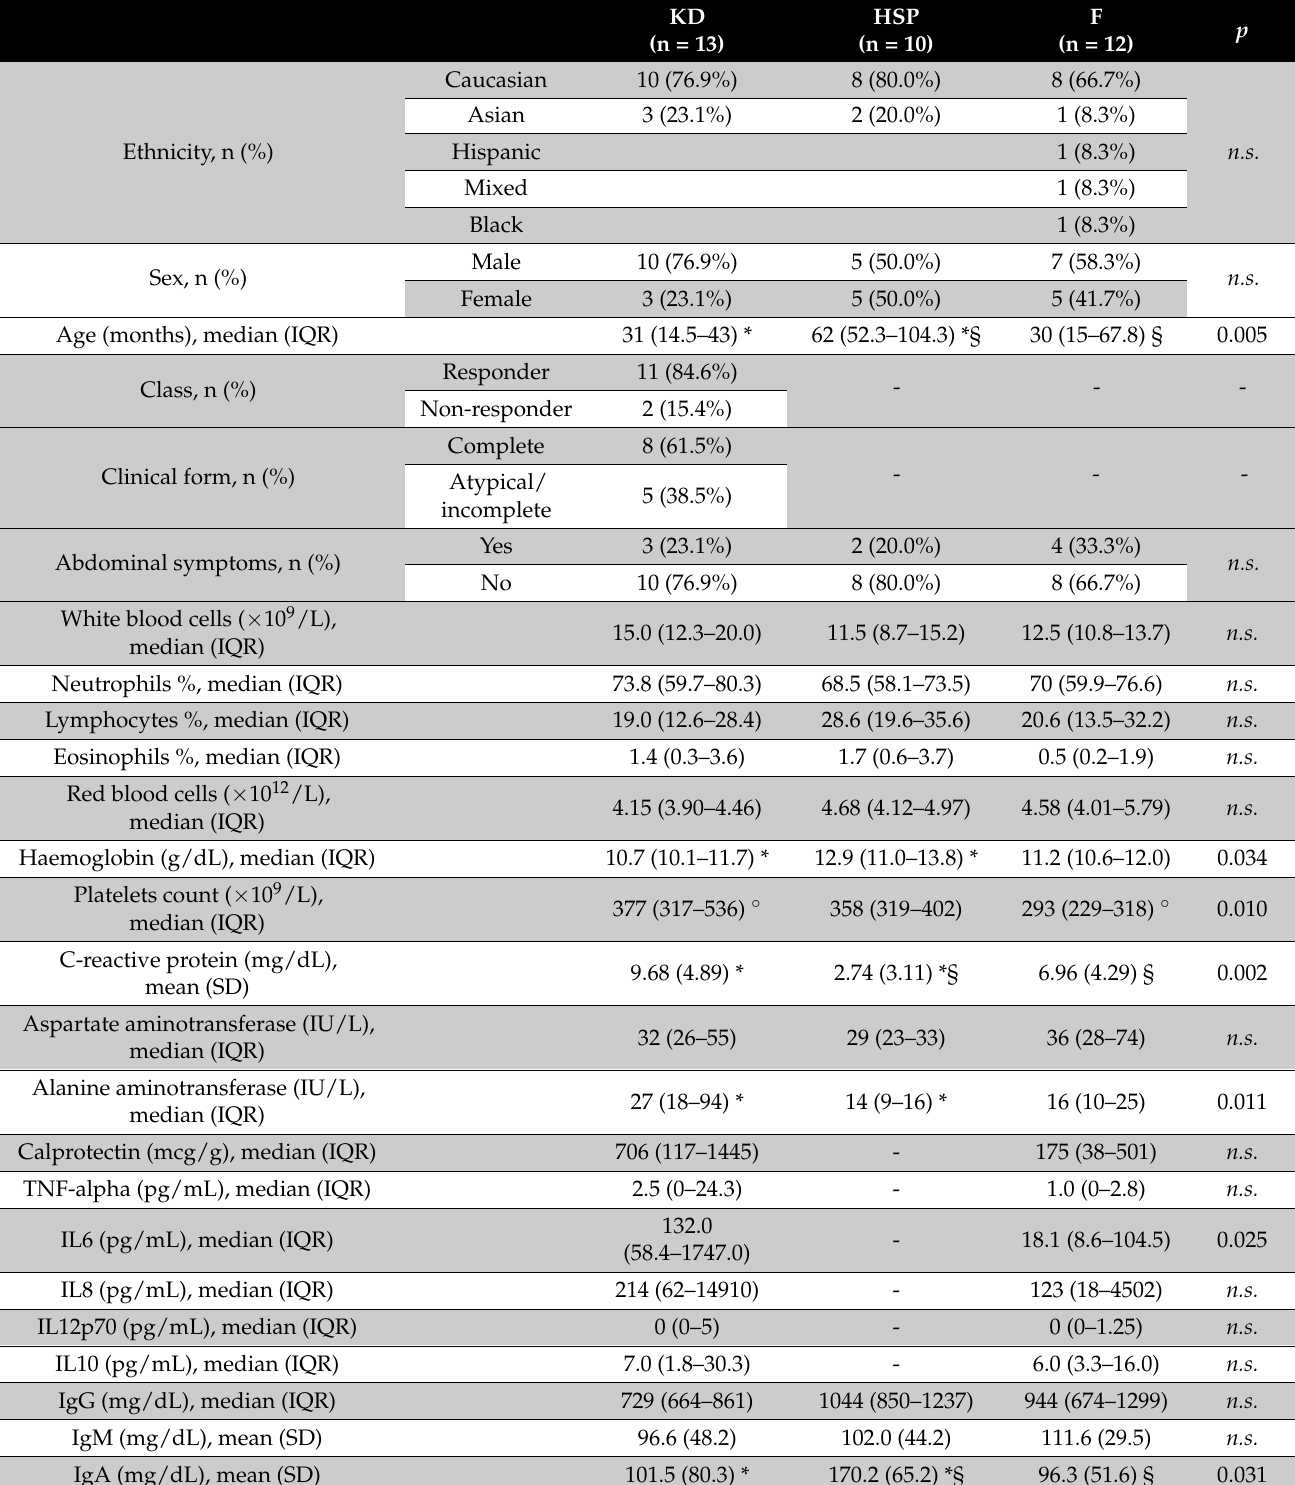
Table 1. Demographic, clinical and laboratory data of children diagnosed with Kawasaki disease (KD), Henoch–Schönlein purpura (HSP) and non-KD febrile illness